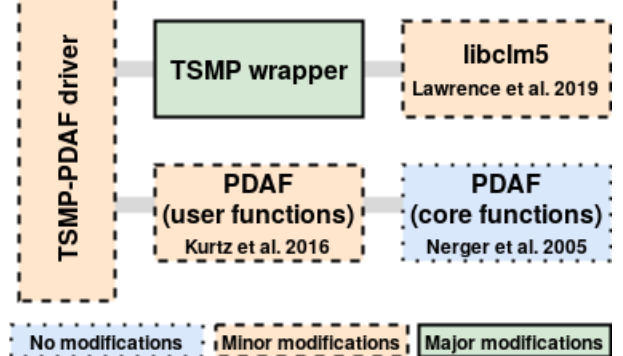
Figure 1. Components of TSMP CLM5 + PDAF highlighting the distinct separation of PDAF functionality, TSMP driver and wrap- per, and CLM5 pseudo-library. Modifications are in relation to the implementation by Kurtz et al.